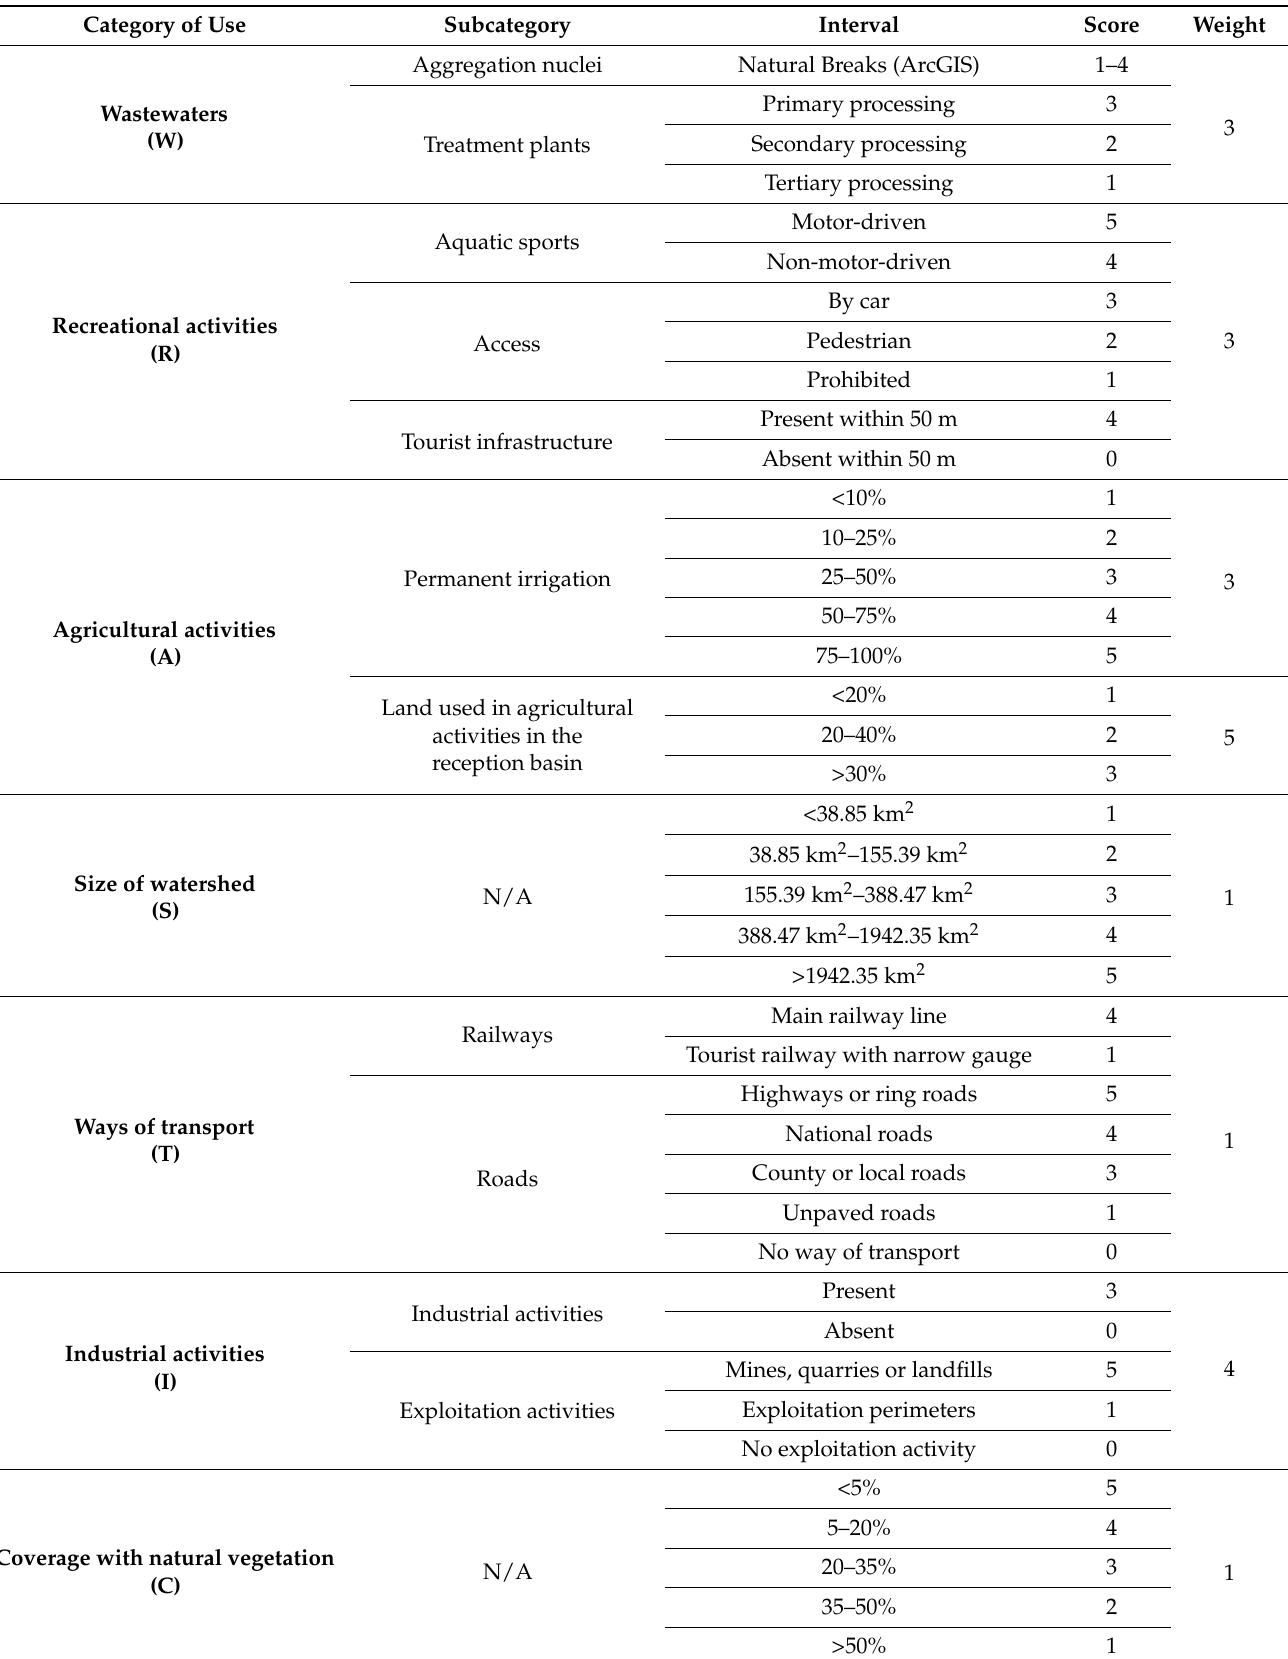
Table 4. Weights of indicators used in the calculation of the WRASTIC